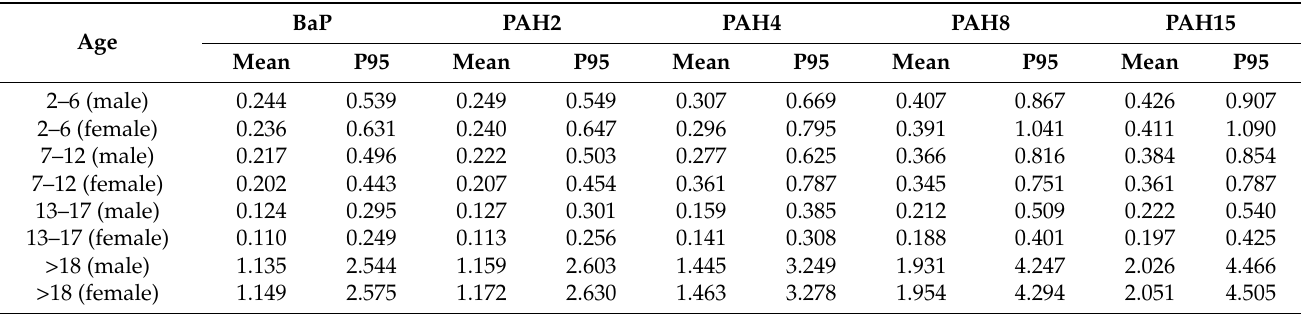
Table 6. CDIs of PAHs (ng BaPeq/kg bw day) for average body masses using the observed mean concentration of BaP, PAH2, PAH4, PAH8, and PAH15 for each species based on different daily consumption of vegetable oils by males and